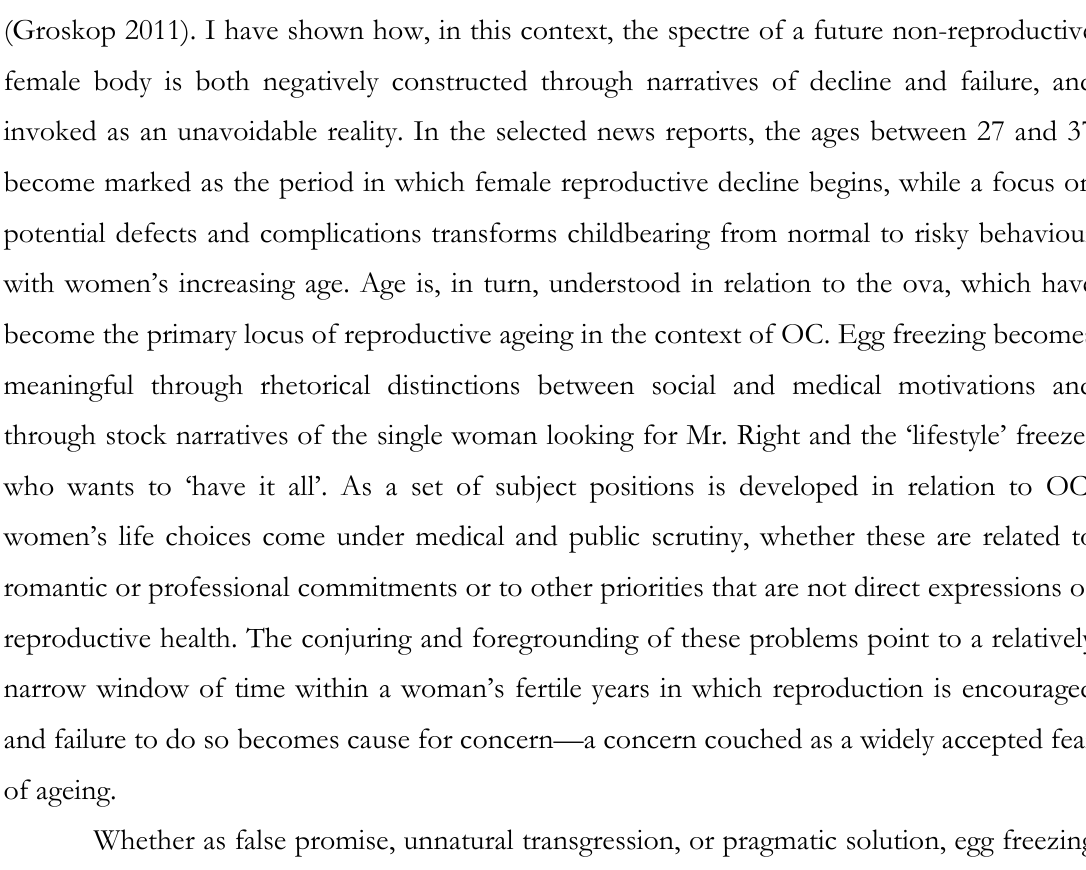
Lucy van de Wiel, For Whom The Clock Ticks: Reproductive Ageing and Egg Freezing in Dutch and British News